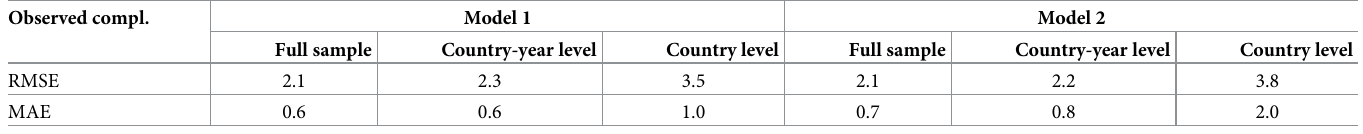
Table 4. Model goodness of fit by level of observed death registration completeness (%), full sample and country-year and country level out-of-sample validation, Models 1 and 2, both sexes. Observed